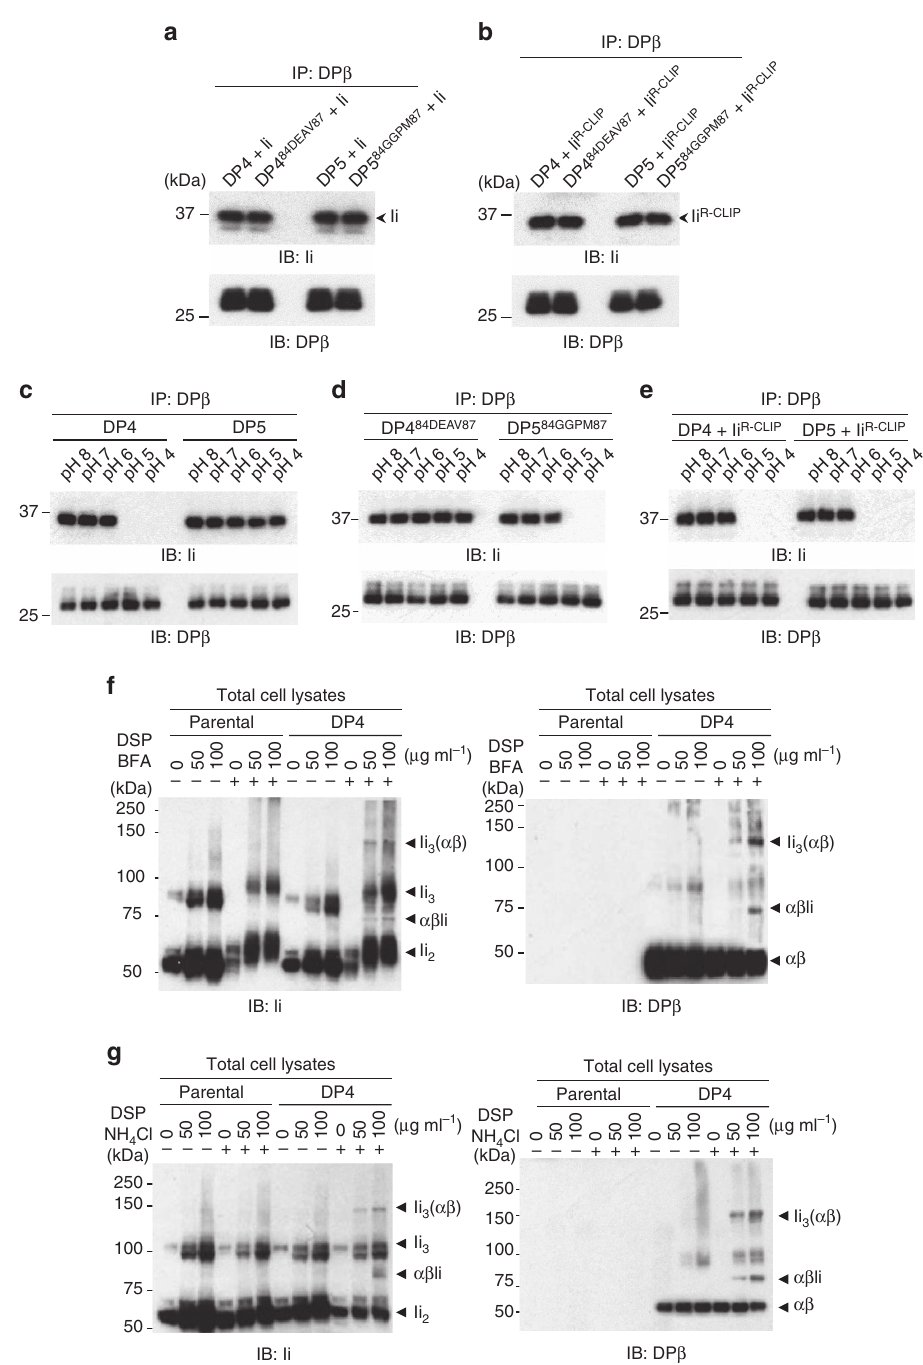
Figure 5 | DP 84GGPM87 binds to Ii via a non-CLIP region(s) in neutral pH conditions. ( a , b ) HEK293 cells were transfected with the indicated combinations of genes. Total cell lysates were immunoprecipitated with anti-DP b mAb and immunoblotted with anti-Ii or DP b mAb. ( c – e ) Lysates of T2/DP transfectants ( c , d ) or HEK293 cells transfected with the indicated combinations of DP and Ii R-CLIP genes ( e ) were immunoprecipitated with anti-DP b mAb. Note that T2 cells naturally express Ii. The immunoprecipitates were washed with buffer of graded pH as indicated and immunoblotted with anti-Ii or DP b mAb. ( f , g ) T2 and T2/DP4 were cultured in the presence or absence of 10 m g ml (cid:2) 1 BFA ( f ) or 40mM NH 4 Cl ( g ). Cells were further treated with DSP at the indicated concentrations for 2h. Non-reduced samples were immunoblotted with anti-Ii (left) or DP b (right)